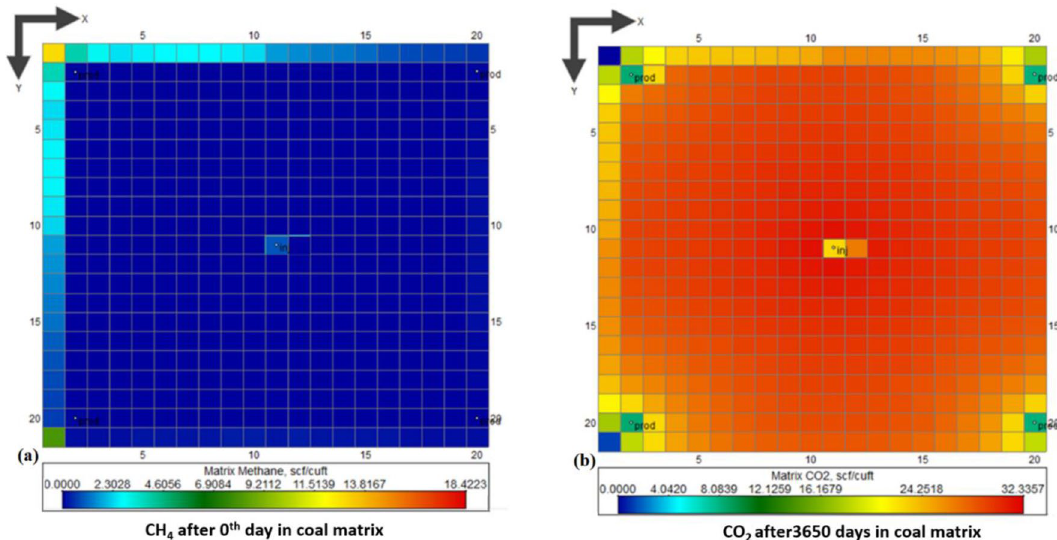
Figure 8. CH 4 –CO 2 matrix concentration after 0 day and 3650 days respectively: ( a ) CH 4 ( b ) CO 2 .